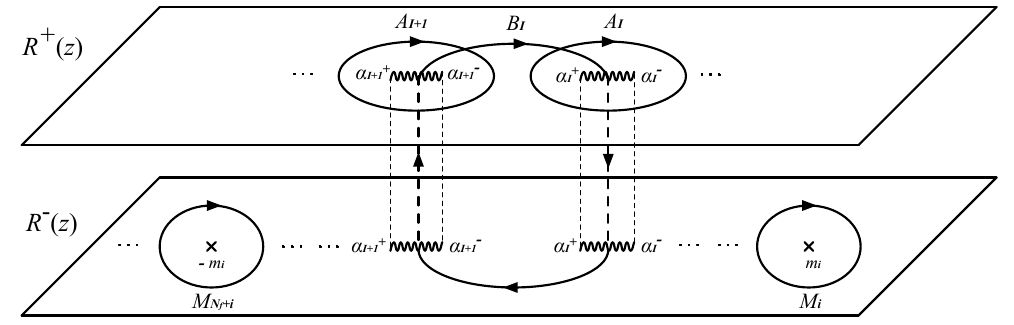
Figure 15 . A I , B I , and M i -cycles depicted on the two copies of complex plane with coordinate z . R − ( z ) is defined on the upper complex plane while R + ( z ) is defined on the lower complex plane. The two complex planes are connected at the branch cuts and they give the Riemann surface as a whole. Note that the structure is analogous to figure 3, apart from the locations of M ( i = 1 , · · · , N f